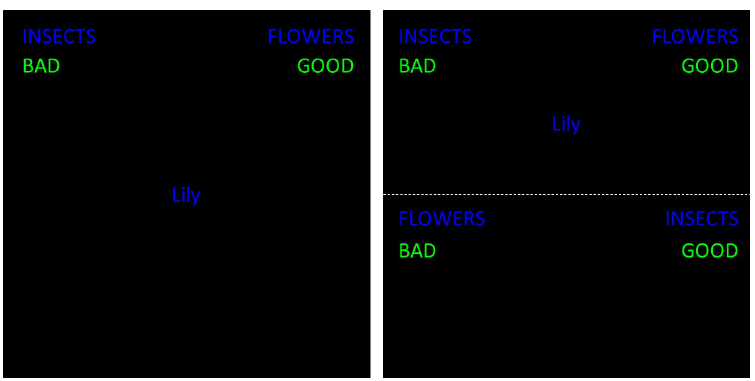
Fig 2. Example trials on a multi-block IAT (left panel) and a single-block IAT (right panel). Original stimuli were presented in German.